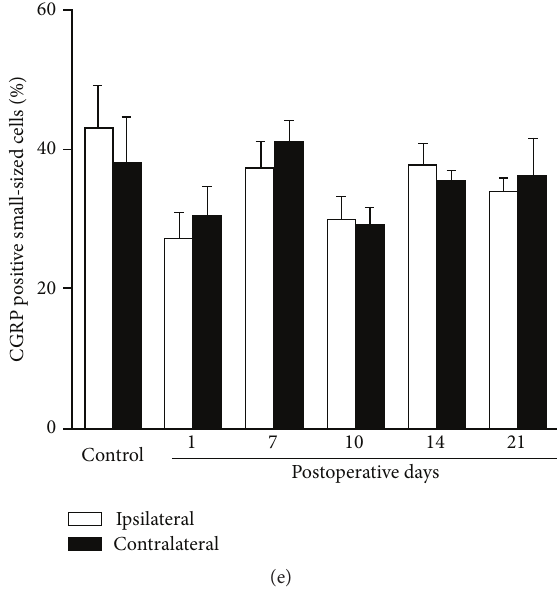
Figure 8: CGRP expression was significantly increased in large- and medium-sized neurons but not in small-sized neurons in ipsilateral and contralateral DRGs following the mCCD. (a) CGRP expression in ipsilateral large- and medium-sized DRG neurons in control and mCCD rats (on 10th postoperative day, inset: higher magnification, scale bar = 20 𝜇 m). (b) CGRP expression in ipsilateral small-sized DRG neurons in control and mCCD rats (on 10th postoperative day; inset: higher magnification, scale bar = 20 𝜇 m). (c) Percentage of CGRP positive cells in ipsilateral and contralateral DRGs following the multiple DRG compression on the 1st, 7th, 10th, 14th, and 21st postoperative day. (d) The percentage of CGRP positive cells in ipsilateral and contralateral large- and medium-sized DRG neurons was significantly increased following the chronic compression of DRGs. (e) The percentage of CGRP positive small-sized neurons in ipsilateral and contralateral DRGs was significantly increased following the chronic compression of DRGs. Scale bar = 50 𝜇 m (a-b). Bonferroni test, 𝑃 s < 0.001 , compared to the bilateral DRG neurons of control